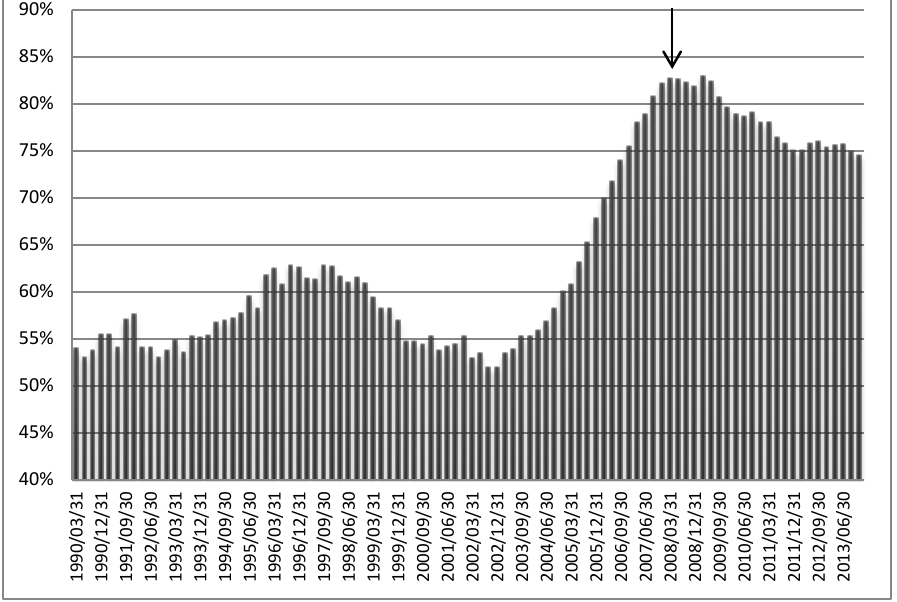
FIGURE 1: Household debt-to-disposable income ratio Source: SARB, June